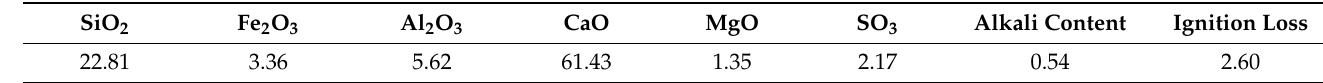
Table 1. Chemical composition of cement (%).